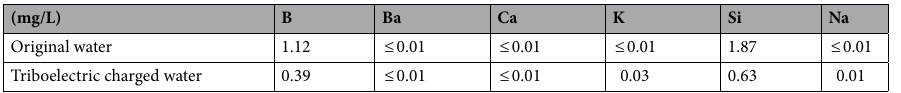
Table 3. Metal and inorganic elements in the water before and after triboelectric charging process.